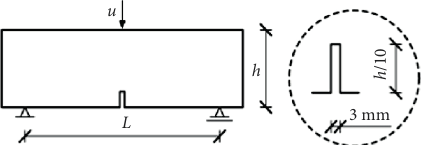
Fig. 14. The values of the objective function versus different dilation angles in dual-border cut test